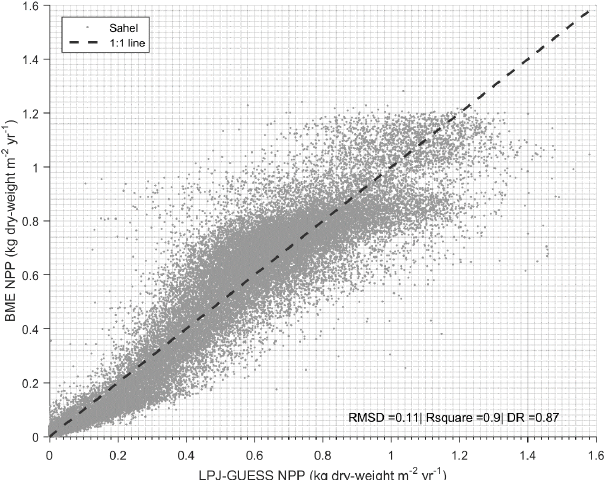
gauge BME performance against LPJ-GUESS simulations.